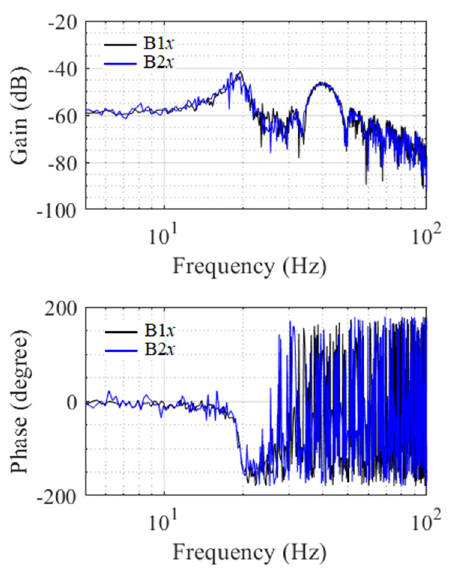
Figure 8. Measured frequency responses of the two bearings in the X -direction using the excitation force generated by the motor windings.